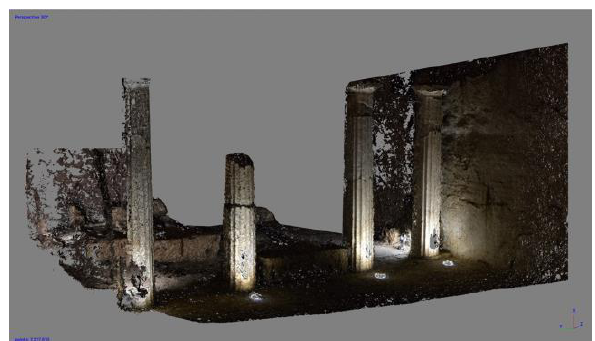
Figure 15. The Tomb of Persephores in Verghina. Cloud of points, detail from the west.